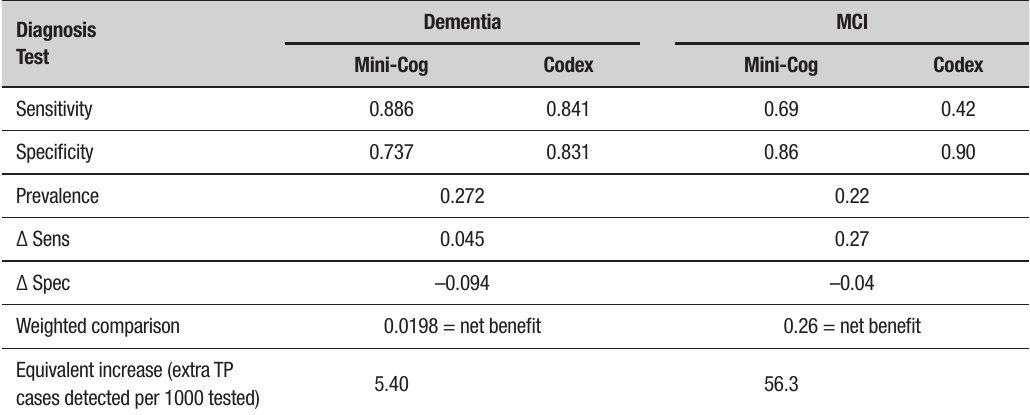
Table 4. Weighted comparison of Mini-Cog and Codex for diagnosis of dementia vs. no dementia (n=162) and MCI vs. subjective memory complaint